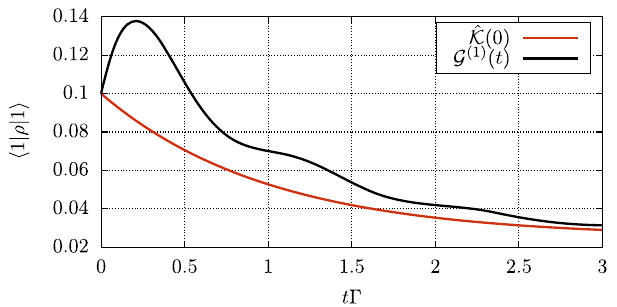
FIG. 5. Decay of the occupation h 1 j ρ ð t Þj 1 i in the resonant level model for ε − μ ¼ 2 π Γ , T ¼ 0 . 1 × Γ = ð 2 π Þ obtained from G ð 0 Þ ð t Þ ¼ ˆ K ð 0 Þ and G ð 1 Þ ð t Þ ¼ G ð t Þ . The former corresponds to ˆ K a Markov semigroup approximation using ð 0 Þ , which is never able to describe the initial growth of the occupation away from the stationary value. When used as initial guess in the transient iteration the exact solution is recovered by the fixed-point equation (10) after a single